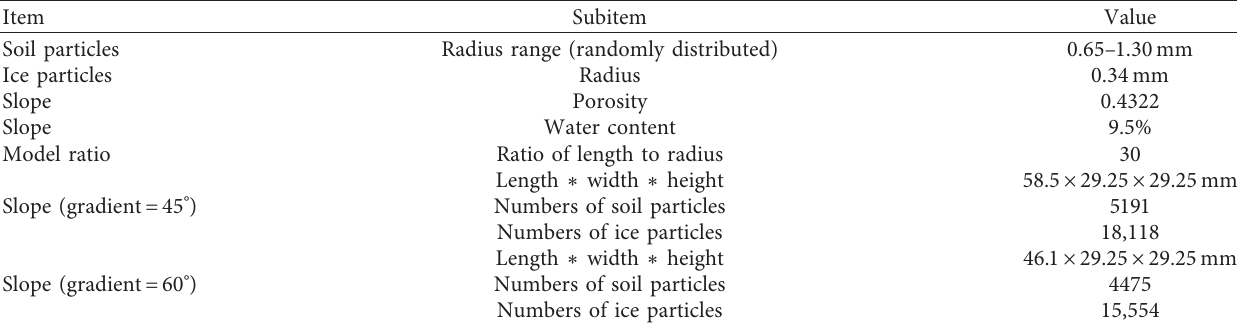
Table 3: Parameters of geometry model.